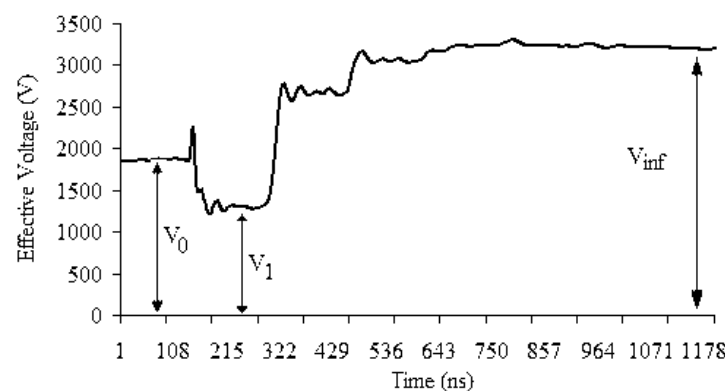
Figure 1. TDR Trase 6050 X1 plot used in the determination of V